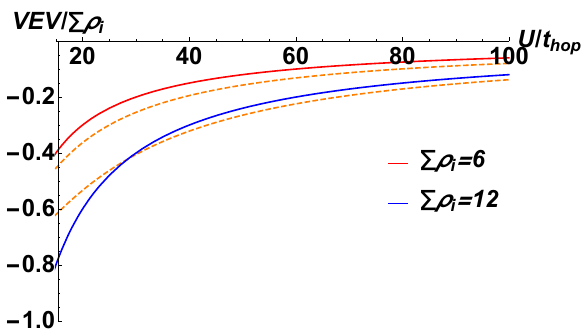
Figure 11 . VEV = P (cid:26) i in the Mott insulator phase as a function of U=t hop with (cid:12)xed parameters M 2 = 0, w = 0, (cid:21) = 1 = (cid:3) 2 , (cid:3) (1 ; 1) = 3 = (2(cid:3)), and other (cid:3) ( p;r ) = 0, where the parameter (cid:3) (cid:0) is speci(cid:12)ed by eq. (3.10). The orange curves describe the e(cid:11)ective hopping of the SU(3) Bose- Hubbard model with (cid:12)xed numbers of particles p = 2 ; 4 per species. Total numbers of bosons are 6 ; 12, respectively. The parameters were (cid:12)xed by matching to second order perturbation